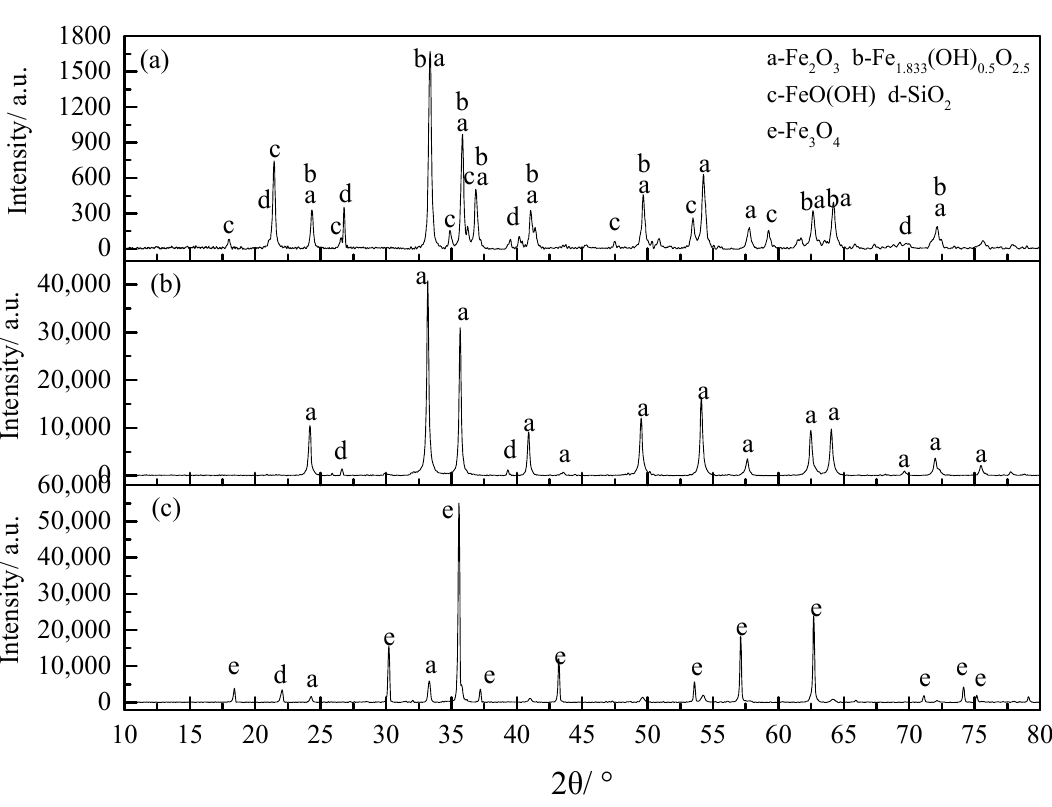
Figure 5. XRD physical phase analysis results of #2 iron ore after thermal decomposition at different temperatures. ( a ) raw material; ( b ) 750 °C; ( c ) 1350 °C.